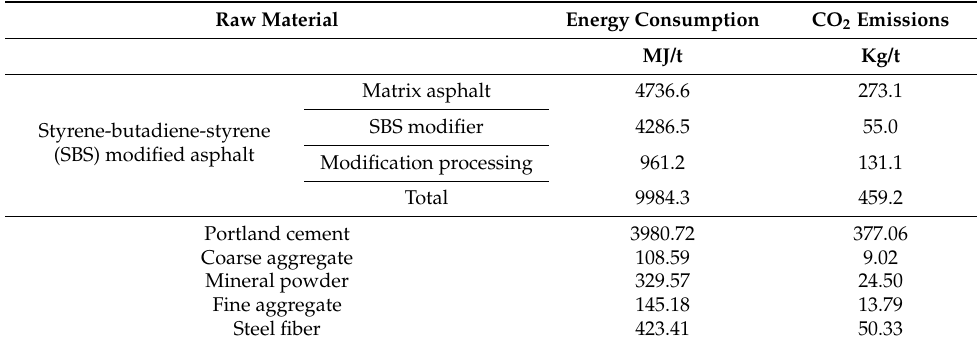
Table 3. List of raw material production.